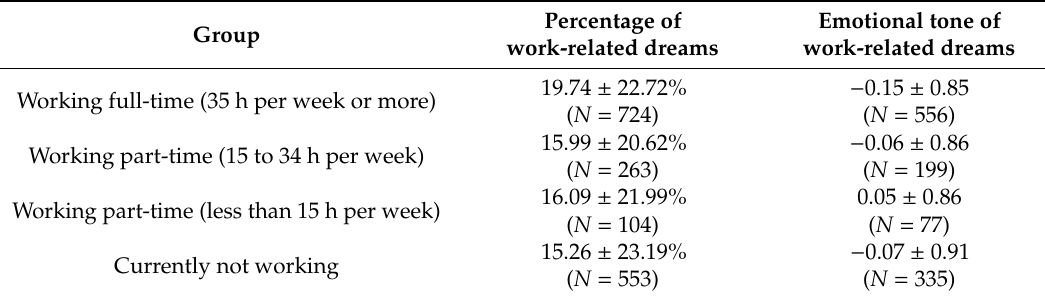
Table 3. Means and standard deviations for the retrospectively estimated percentages of work-related dreams and the overall emotional tone of work-related dreams.